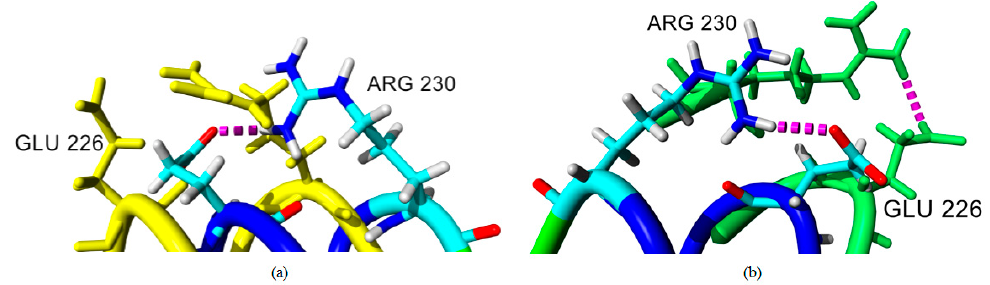
Figure 8. Ion pair interaction in earth-grown and space-grown T1 lipase structures: ( a ) Superpose of earth-grown T1 lipase crystal structure (color in elements) and structure at 20 ns (color in yellow); ( b ) Superpose of space-grown T1 lipase crystal structure (color in elements) and structure after 20 ns of trajectory (color in green). Ion pair interaction is indicated using dotted lines in magenta.